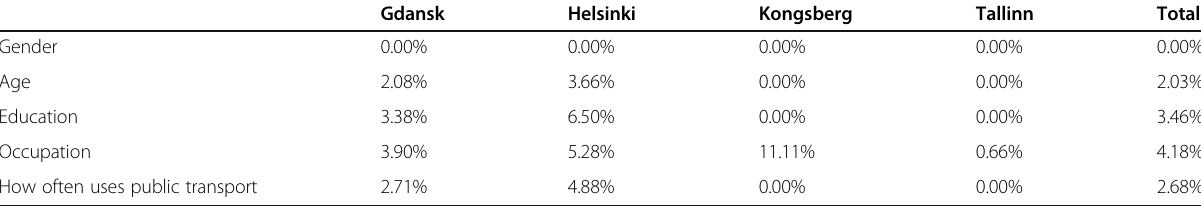
Table 1 Percentage of missing data in demographic information